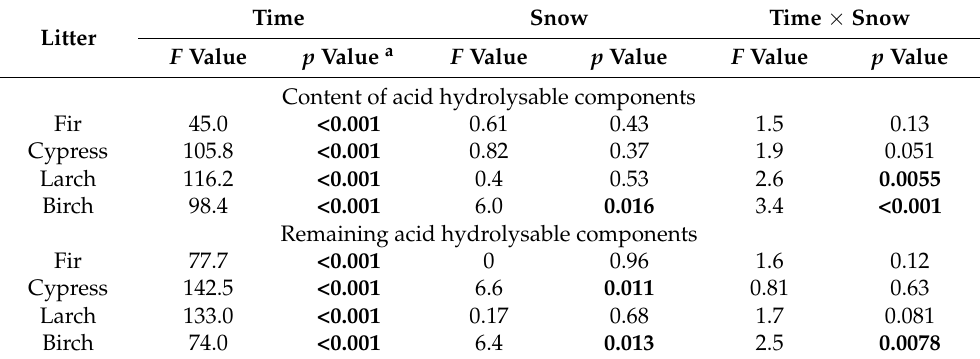
Table 4. Results of repeated measures ANOVA testing for the effects of variation in snow depth over time for each litter species.